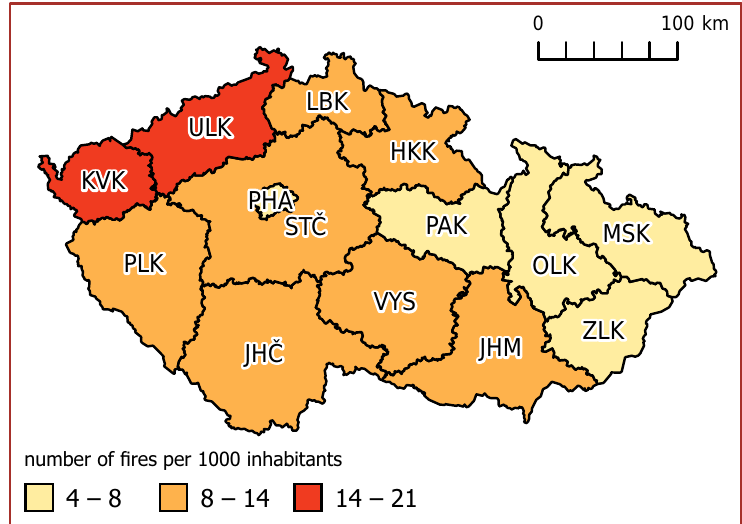
Figure 6. Spatial distribution of wildland fires per 1000 inhabitants in the regions of the Czech Republic. Data refer to the period 1997–2019.